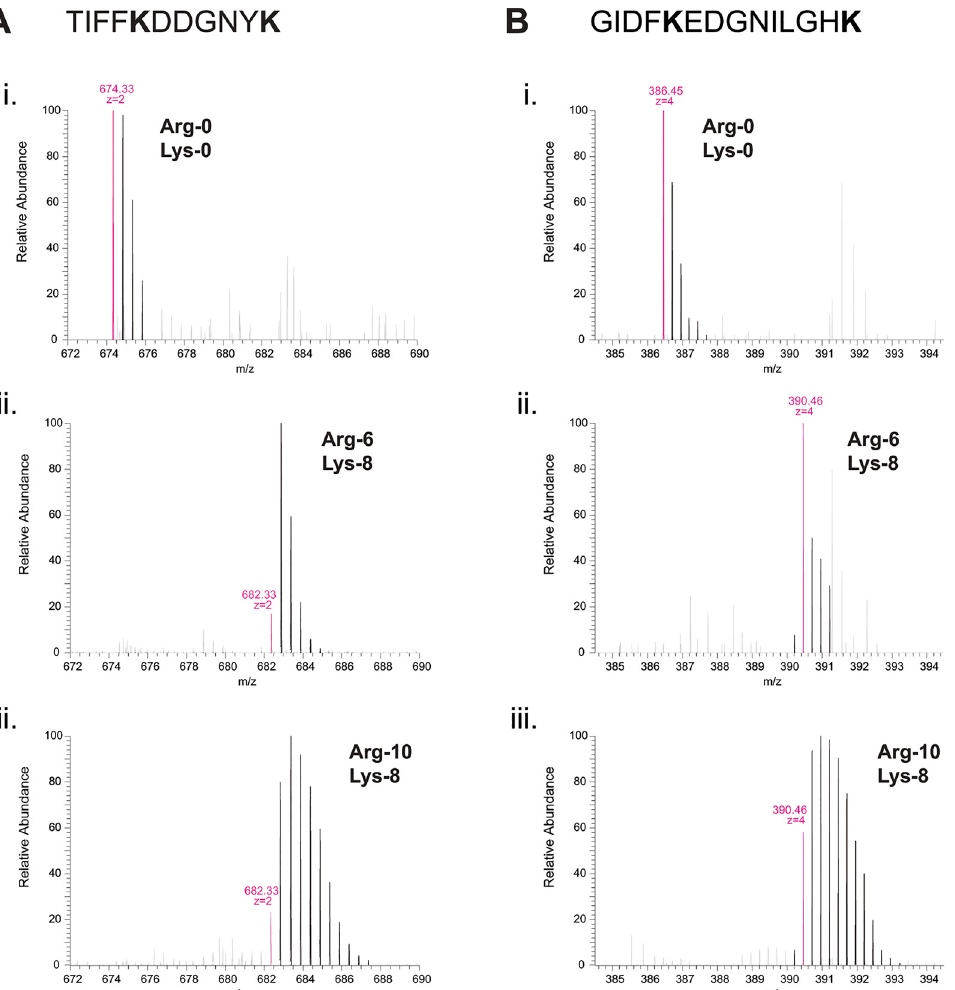
Fig 1. “ Heavy ” -isotope label from 13 C 615 N 4 -arginine (Arg-10) is converted into other amino acids in fission yeast. Mass spectra of tryptic peptides (TIFFKDDGNYK and GIDFKEDGNILGHK in (A) and (B), respectively) from S . pombe Mto2[17A]-GFP fusion protein isolated from car2 Δ arg1-230 lys3-37 cells grown in either (i) unlabeled arginine (Arg-0) and unlabeled lysine (Lys-0), (ii) 13 C 6 -arginine (Arg-6) and 13 C 15 N 2 -lysine (Lys-8), or (iii) 13 C 615 N 4 -arginine (Arg-10) and 13 C 615 N 2 -lysine (Lys-8), as indicated. In peptides from cells grown in Arg-10, additional higher-molecular-mass peaks are observed (iii), indicating conversion of “ heavy ” -isotope label into other amino acids. Such peaks are not observed from cells grown in Arg-6. To simplify comparison, peptides shown here do not contain arginine residues, so the masses of monoisotopic peaks of peptides from cells grown in Arg-6 and Arg-10 are identical (see Fig 2). Mass-to-charge (m/z) ratios of monoisotopic peaks and inferred peptide charge-states are indicated in